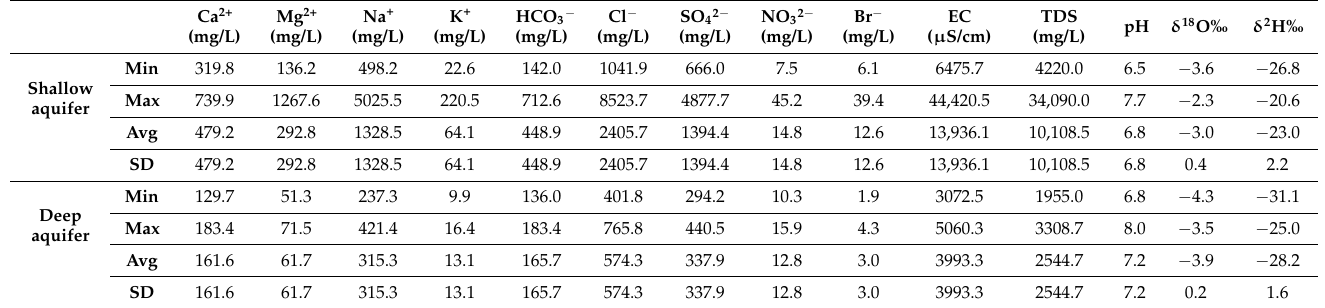
Table 1. Descriptive statistics of the hydrochemical parameters and isotopes of tested GW samples from both